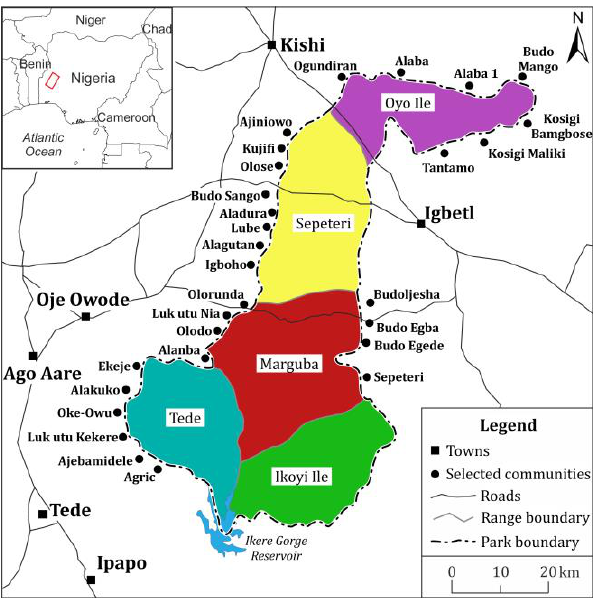
Fig. 1. Map of Old Oyo National